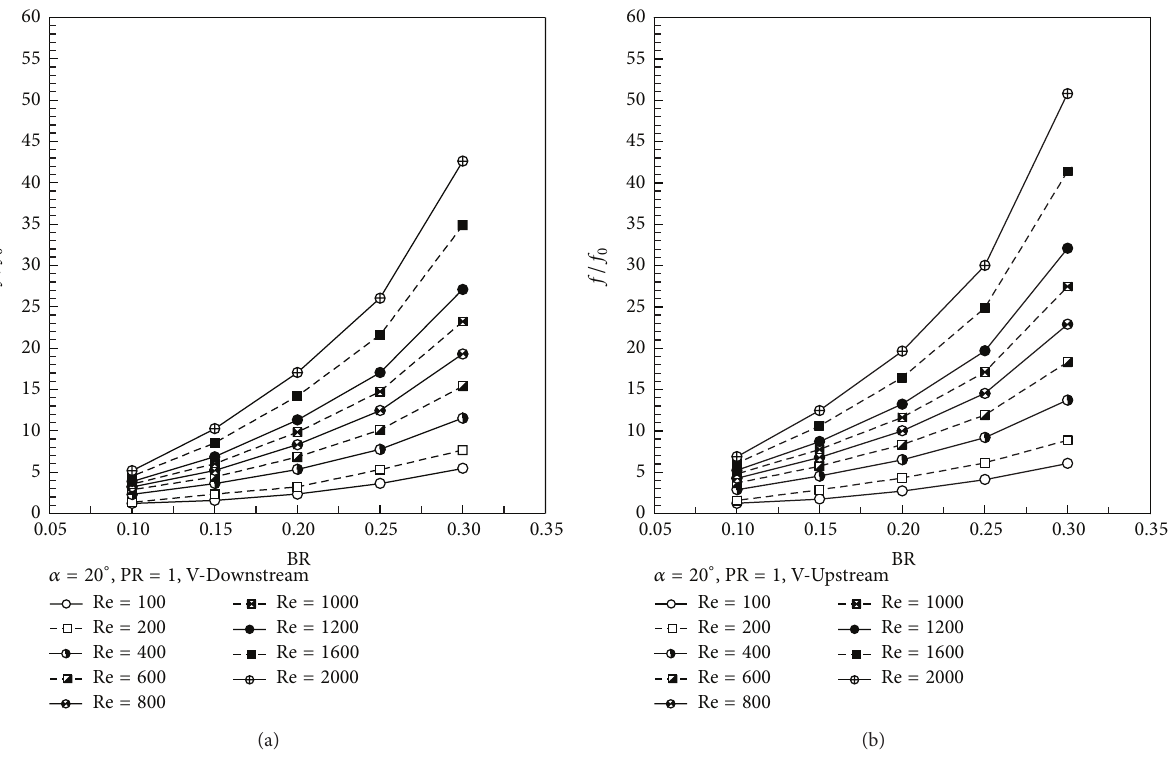
Figure 11: 𝑓/𝑓 0 versus BRs at various Reynolds number values for (a) V-Downstream and (b) V-Upstream.